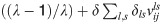
Spatial pattern at given times with different initial value ((λ-1)/λ)+δ∑l,sδlsvijls.Snapshots of the spatial grid at given times t for various l, s when the initial value is selected as ((λ-1)/λ)+δ∑l,sδlsvijls with δ = 0.01, λ = 2.9 and ε = 0.34. (A) spiral wave. (B) traveling wave with the diagonal direction of spatial propagation. (C) trigger wave with the diagonal direction of spatial propagation. (D) trigger wave with the vertical direction of spatial propagation. (E) stationary wave. (F) spatiotemporal chaos.